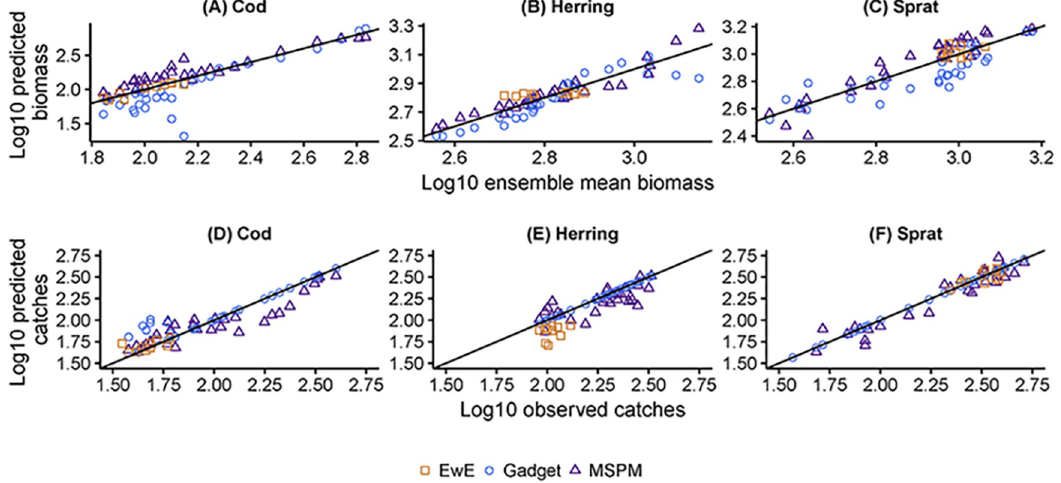
Fig 3. Comparison of model estimates to historical data. Model estimates of spawning stock biomass (A-C) and catches (D-F) from EwE (orange squares), Gadget (blue circles) and MSPM (purple triangles) in relation to the ensemble mean spawning stock biomass (A-C) and observed catches (D-F) of cod (A, D), herring (B, E) and sprat (C, F). The solid black line of slope = 1 and intercept = 0 represents perfect correspondence. Please note that model hindcast period was different among the models (see Methods) and therefore EwE is represented by less data points. Catches in the Gadget model are set to be equivalent to data in case of herring and sprat and for all years < 2004 in the case of cod (Table D in S1 Appendix, chapter